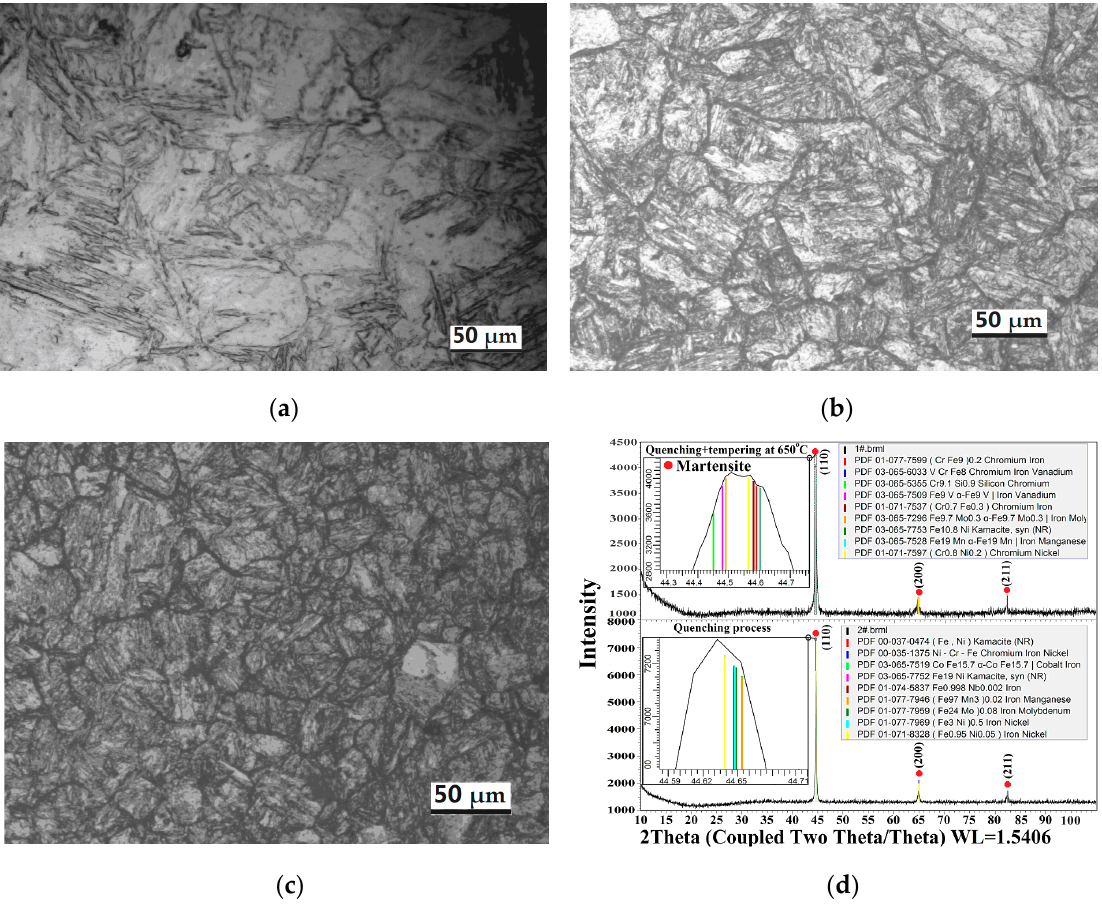
Figure 7. OM and XRD analysis using different quenching cooling methods: ( a ) quenching at 1040 °C with oil cooling; ( b ) quenching at 1040 °C with air cooling and tempering at 650 °C in air cooling; ( c ) quenching at 1040 °C with oil cooling and tempering at 650 °C in air cooling; ( d ) comparison of XRD under various heat treatment processes.